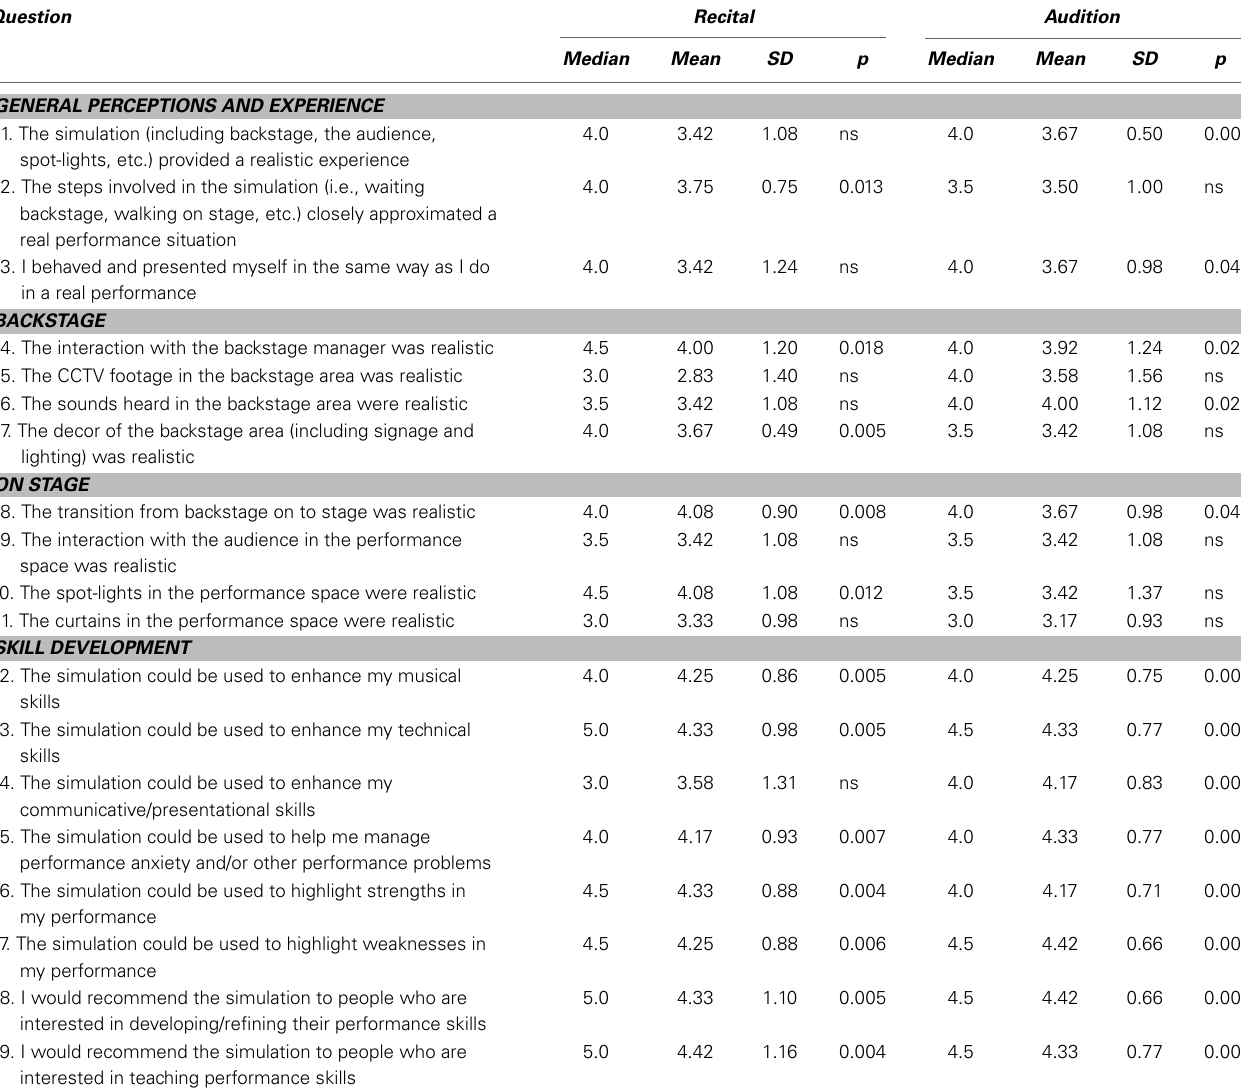
Table 1 | Descriptive statistics for questions in the Simulation Evaluation Questionnaire completed after performing in the recital and audition